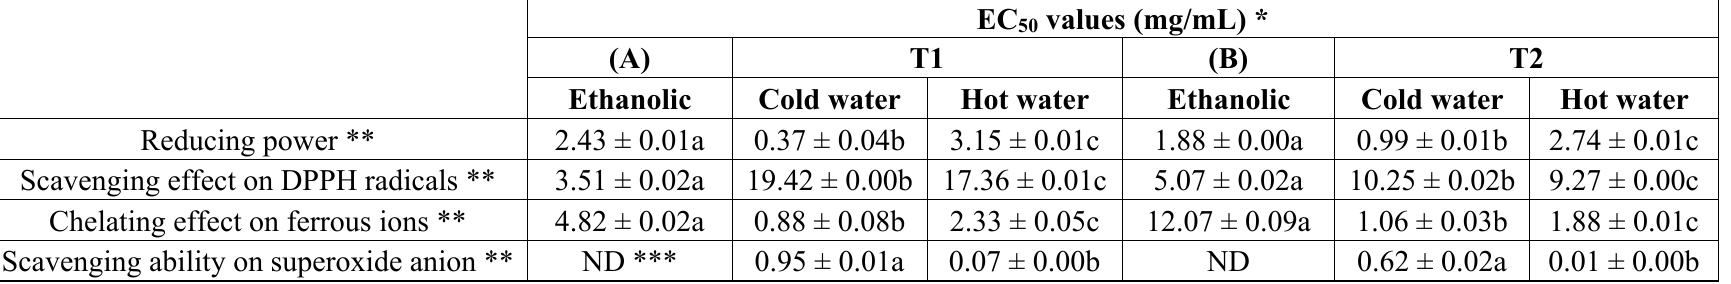
Table 1. EC values of various extracts from Grifola frondosa T1 (A) and T2 (B) for antioxidant properties. 50